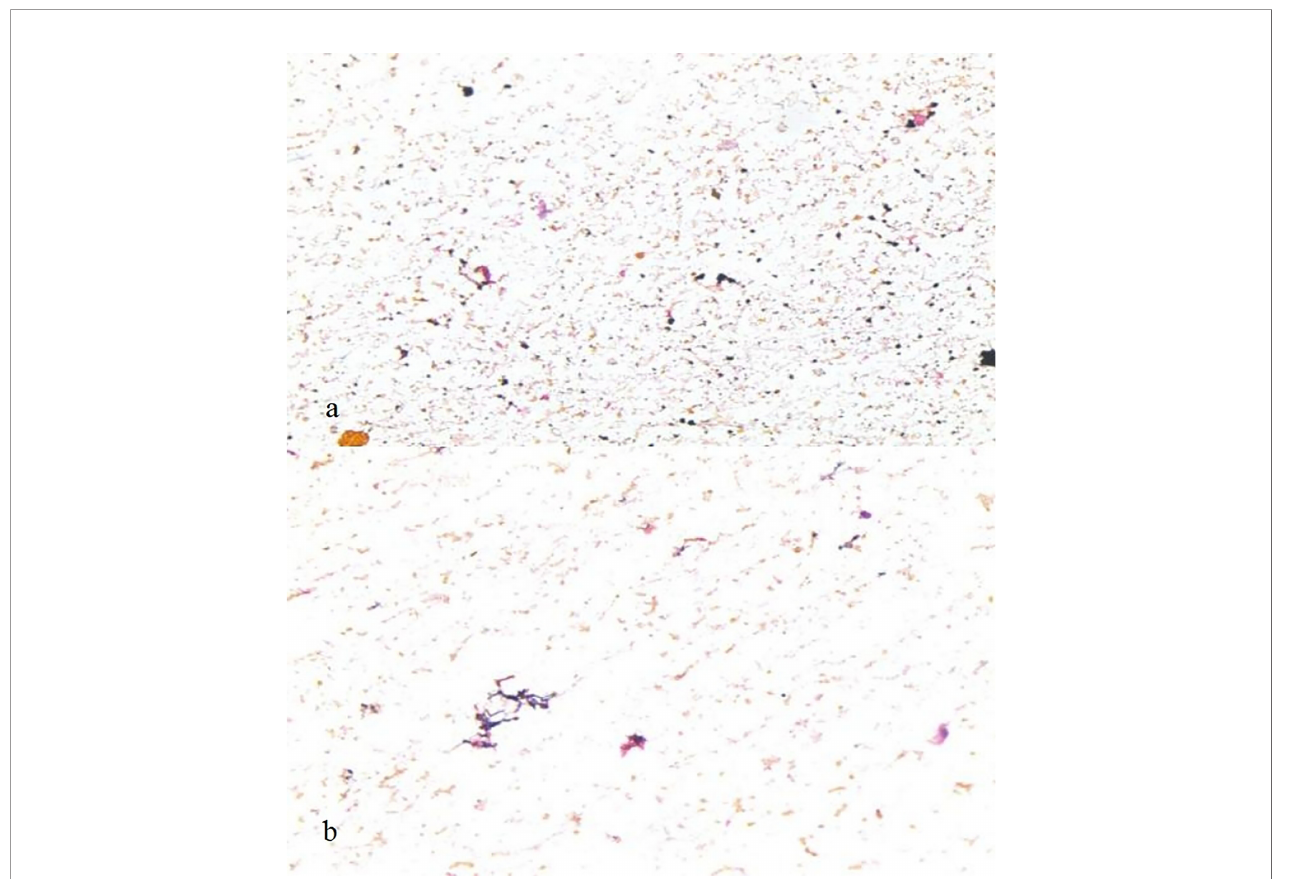
FIGURE 1 | Laparoscopic wash fl uid exfoliation cytology (EC) test after La-NOSE and CLA surgery: a large number of mesothelial cells and lymphocytes are evident by microscopy. a, La-NOSE group; b, CLA